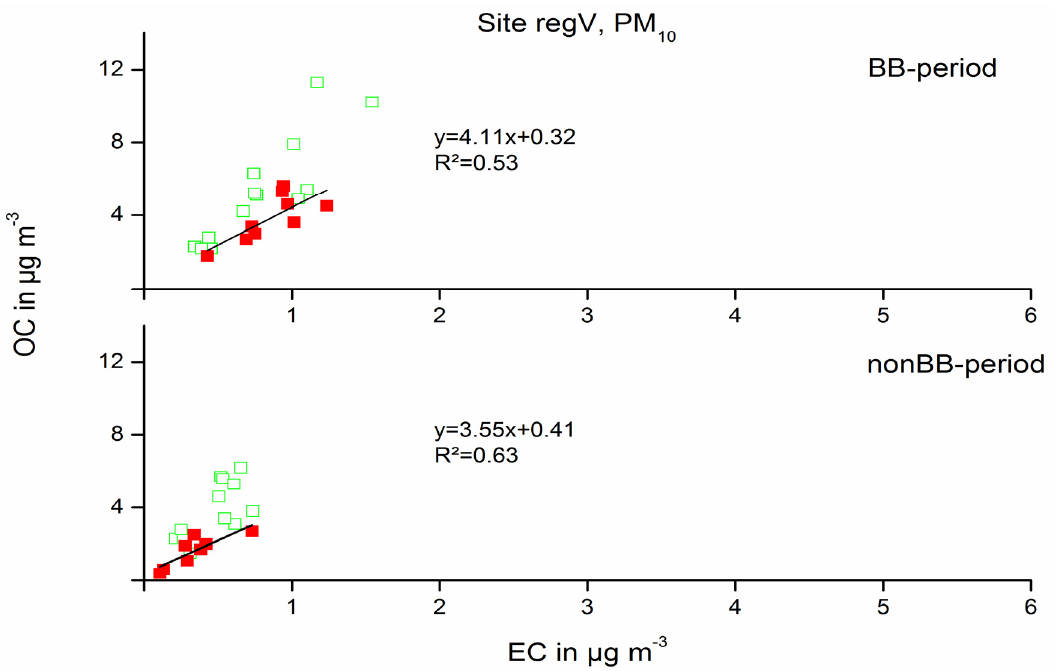
at site regV, PM p